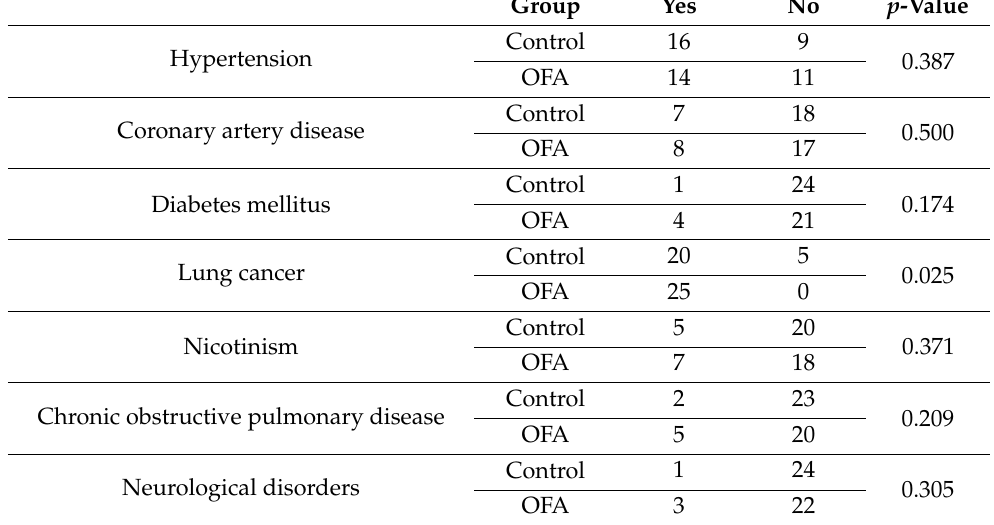
Table 2. Comorbidities in the study groups. Table 3. Surgery types in the study